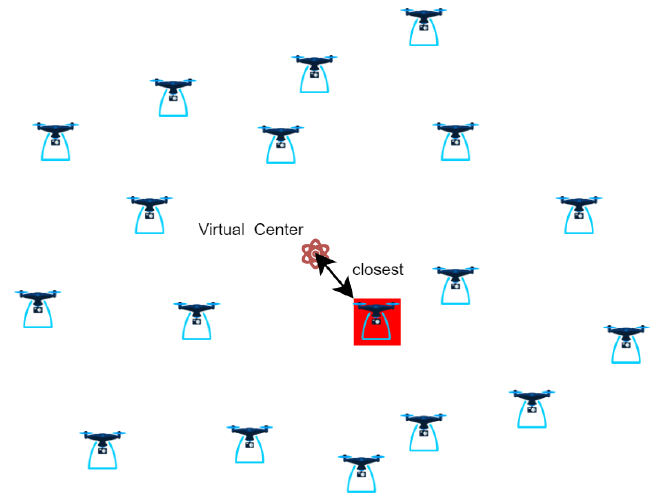
Figure 3. An example of the utilized qualification calculation.